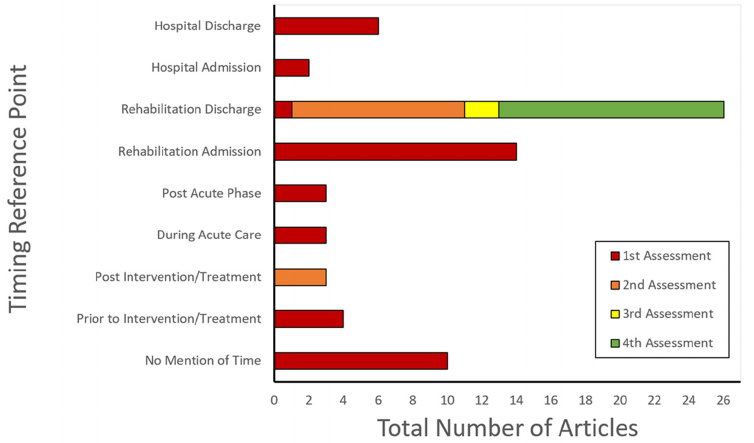
Figure 6. Total number of articles assessing cognitive outcomes in coma survivors relative to reference points other than “time since injury”. Red bars indicate a first assessment timepoint, orange bars indicate a second assessment, yellow bars indicate a third assessment, and green bars indicate a fourth assessment within the same study.